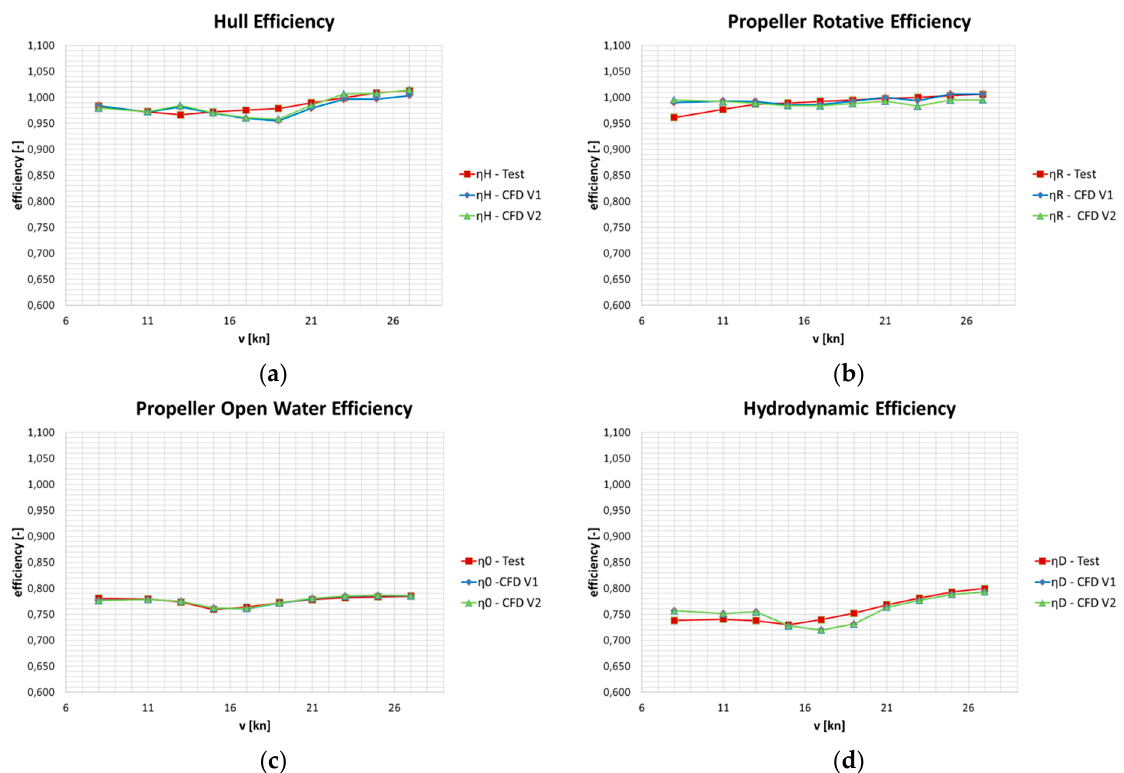
Figure 12 . Full scale propulsive efficiencies as predicted from model tests (left) and CFD (right) for the Stavanger Demon- strator; ( a ) hull efficiency, ( b ) propeller rotative efficiency, ( c ) propeller open water efficiency, ( d ) total propulsive (hydro- dynamic) efficiency